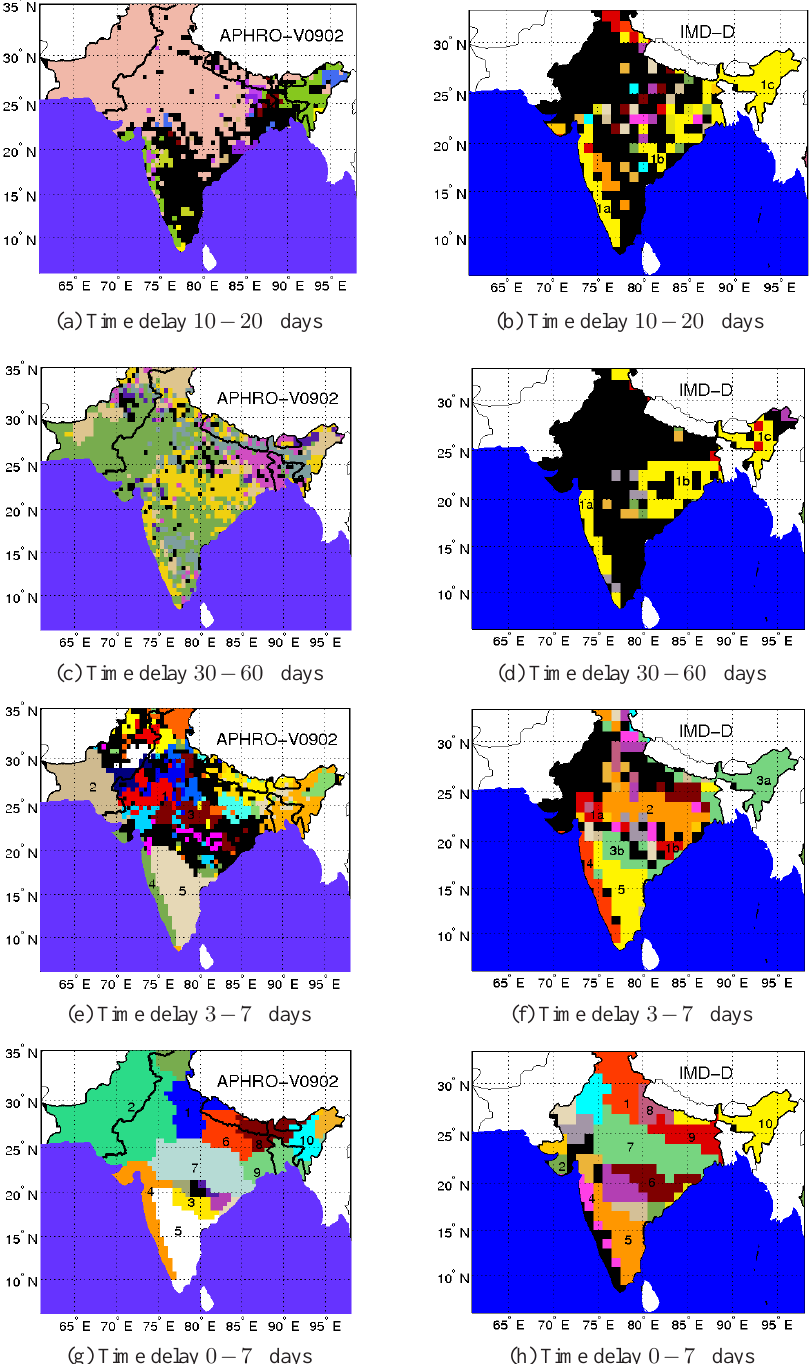
Fig. 9. Results of clustering at different Fig. 9: Results of clustering at different delays Fig. 9: Results of clustering at different delays Fig. 9: Results of clustering at different delays Fig. 9: Results of clustering at different delays Fig. 9: Results of clustering at different delays